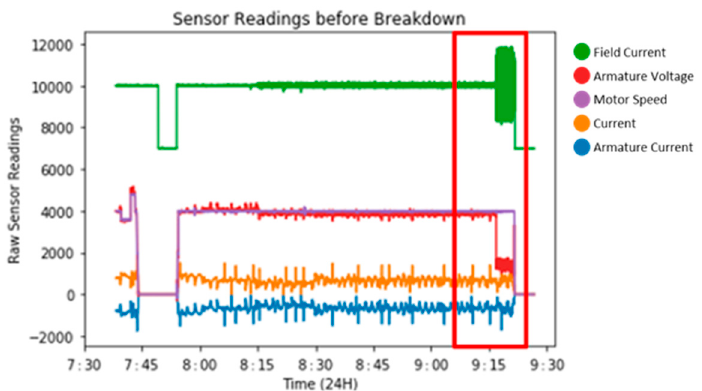
Figure 2. Time series sensor dataset displaying at 1 h 45 min window of data; this is directly before the catastrophic failure highlighted in red.